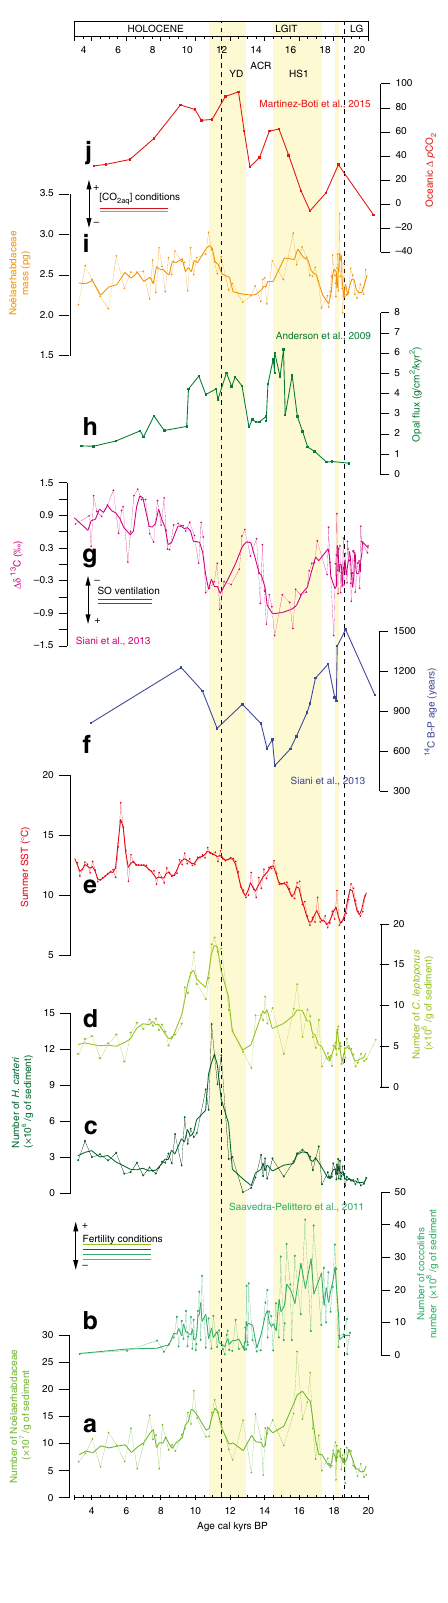
Fig. 2 Southern Ocean productivity and circulation patterns during the last deglaciation. a , c , d Number of Noëlaerhabdaceae, H. carteri and C. leptoporus at site MD07-3088 (/g of sediment), with an error bar of ±1%. b Number of coccoliths at site ODP 1233 (/g of sediment) 29 . e Summer sea surface temperatures (SST, °C) using the Modern Analogue Technique 14, 31 . f 14 C age difference between paired benthic and planktonic foraminifera ( 14 C B-P) 14 . g Δ δ 13 C = δ 13 C G. bulloides – δ 13 C C. (pg) at site MD07-3088 with an error bar of ±3%. j Surface ocean Δ p CO2 reconstruction for ODP 1238 15 . LG and LGIT are for Late Glacial and